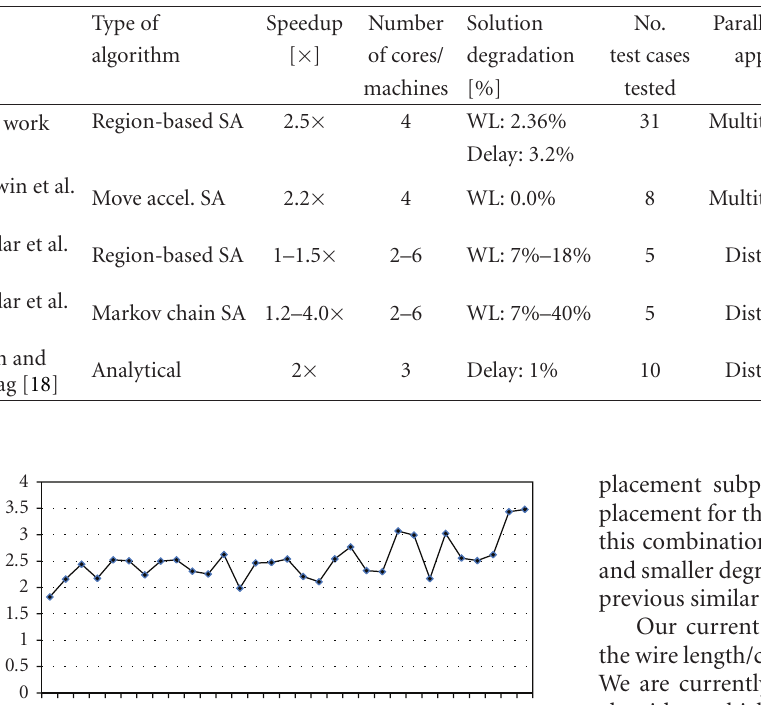
Table 2: Qualitative comparison of the proposed parallel VPR placement algorithm against previously proposed parallel placement algorithms from the FPGA domain. NA stands for not available.